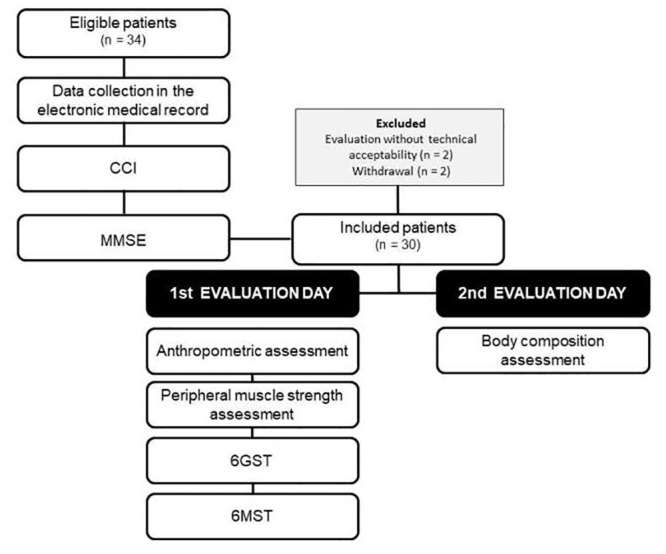
Flowchart of data collection.CCI: Charlson comorbidity index; MMSE: mini mental state examination; 6GST: six-meter gait speed test; 6MST: six-minute stepper test.